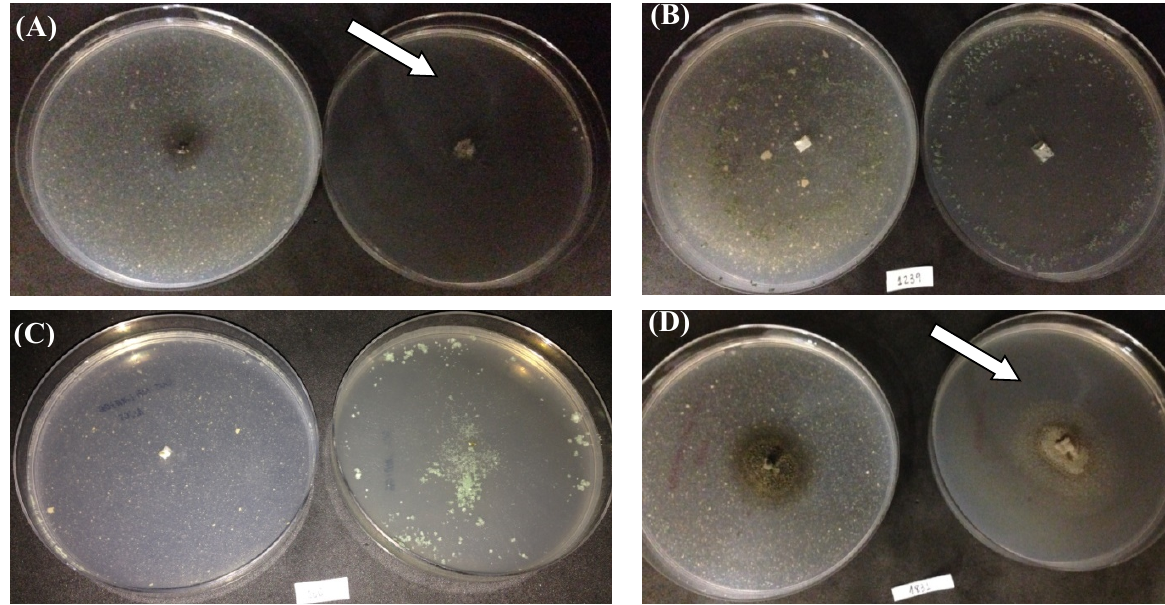
Figure 5. Qualitative assay for probing cutinase production using promising strains. Note. ( A ). C. trifolii CBMAI 2111; ( B ). T. atroviride CBMAI 2073; ( C ). T. sp. CBMAI 2071; ( D ). C. cladosporioides CBMAI 2075. Plates with minimal mineral media containing cutin (left) and polycaprolactone (right) as the sole carbon sources. White arrows indicate the consumption of polycaprolactone and cutin polymer by fungi, in addition to microbial growth.